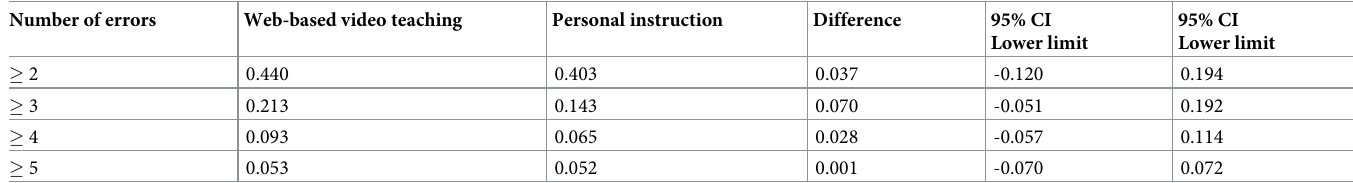
Table 3. 95% Confidence Intervals for the comparison of face-to-face consent discussion with web-based video teaching, with respect to the number of inhalation errors. Number of